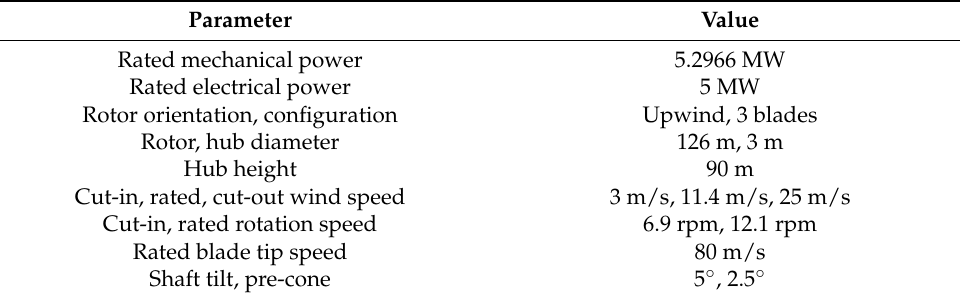
Table 2. Design parameters of the NREL 5-MW wind turbine.